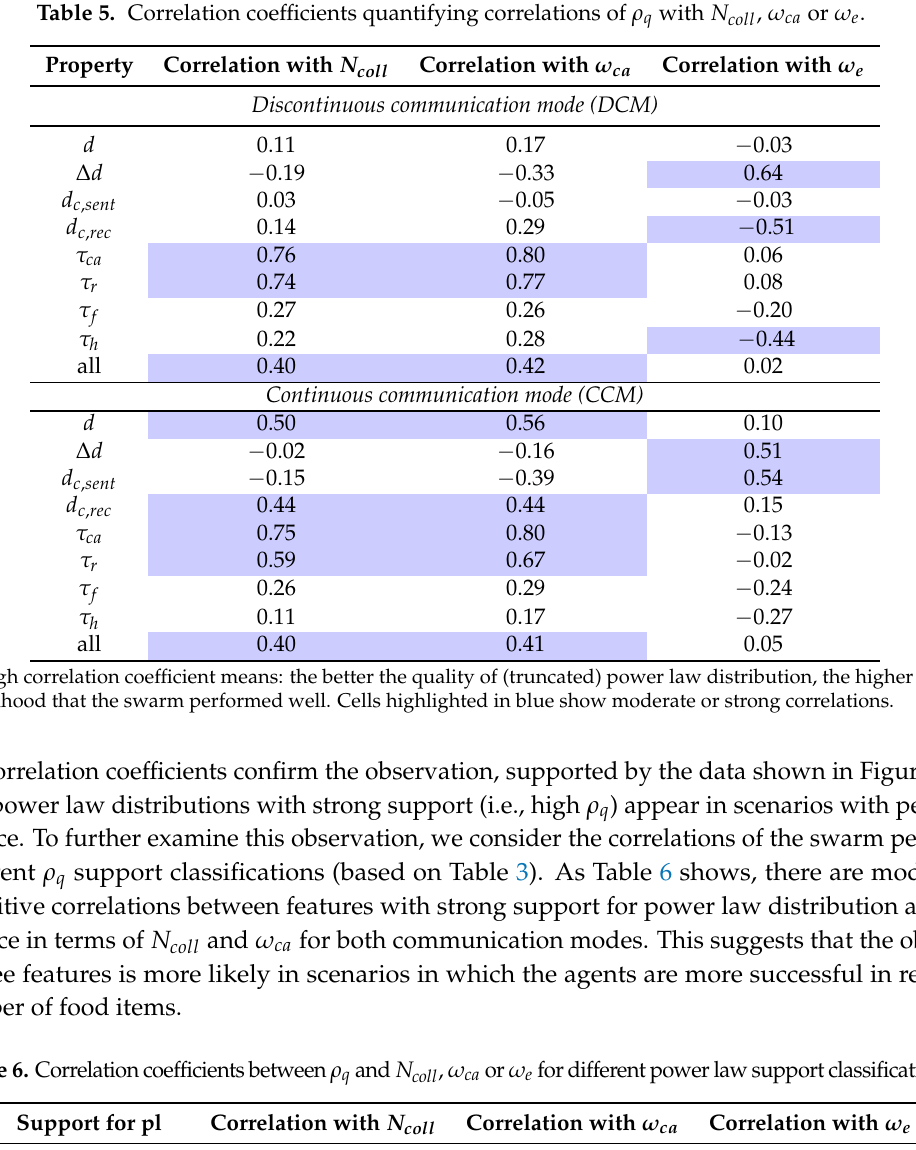
Table 6. Correlationcoefficientsbetween ρ q and N coll , ω ca or ω e fordifferentpowerlawsupportclassifications. Support for pl Correlation with N coll Correlation with ω ca Correlation with ω e Discontinuous communication mode (DCM) weak 0.18 0.18 −